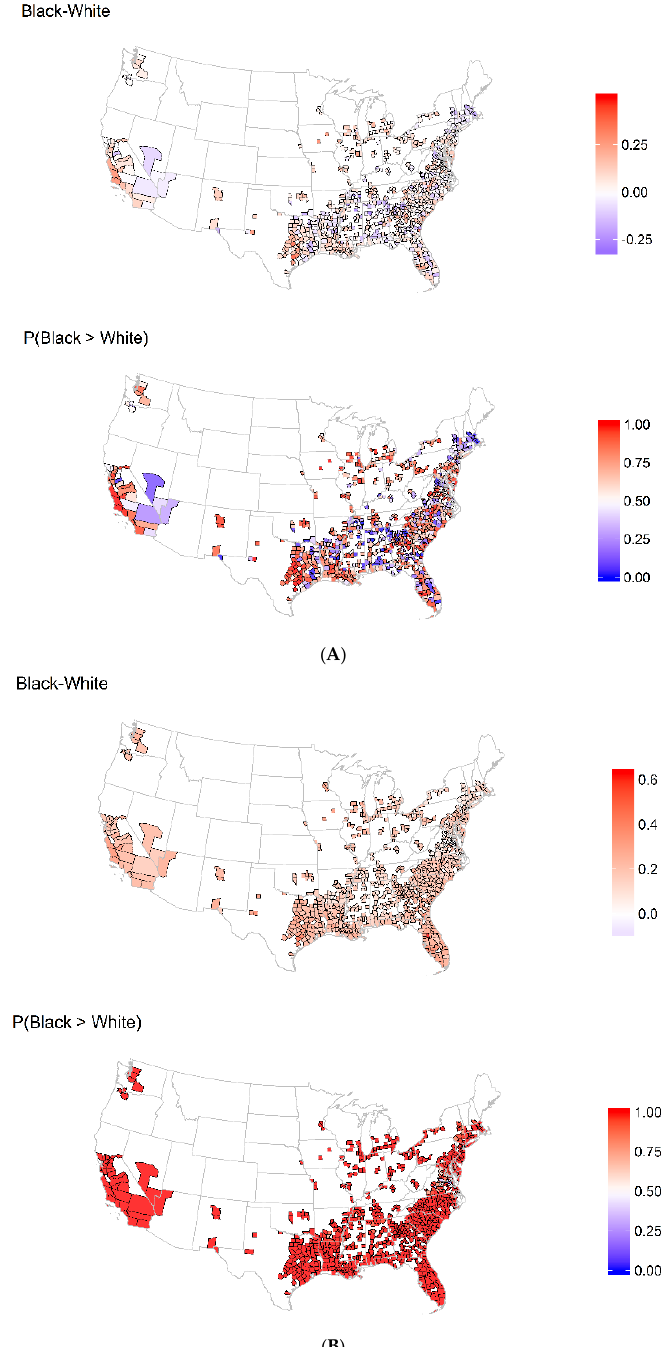
Figure 2. Spatial distribution of BAA – nHW disparities in log rate of heart diseases and stroke mortality among 875 counties in the US. ( A ) Heart Disease; ( B ) Stroke.